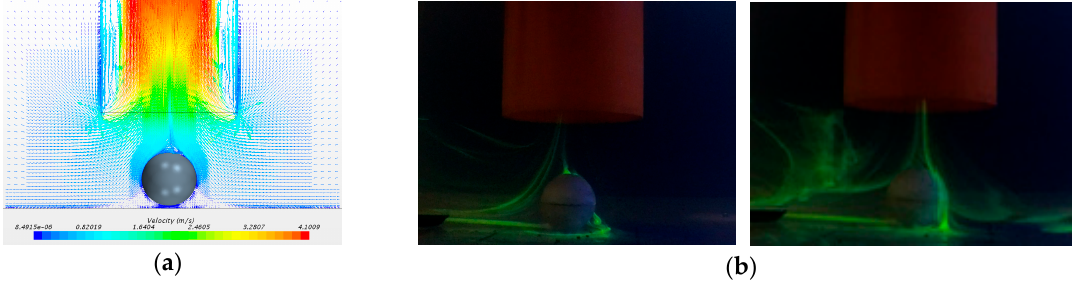
Figure 17. ( a ) Velocity vector distribution from numerical solution ( h = 0.07 m, v = 2 m/s Re = 61162) [16]; ( b ) Flow visualization results ( h = 0.07 m, v = 2 m/s Re = 61162).